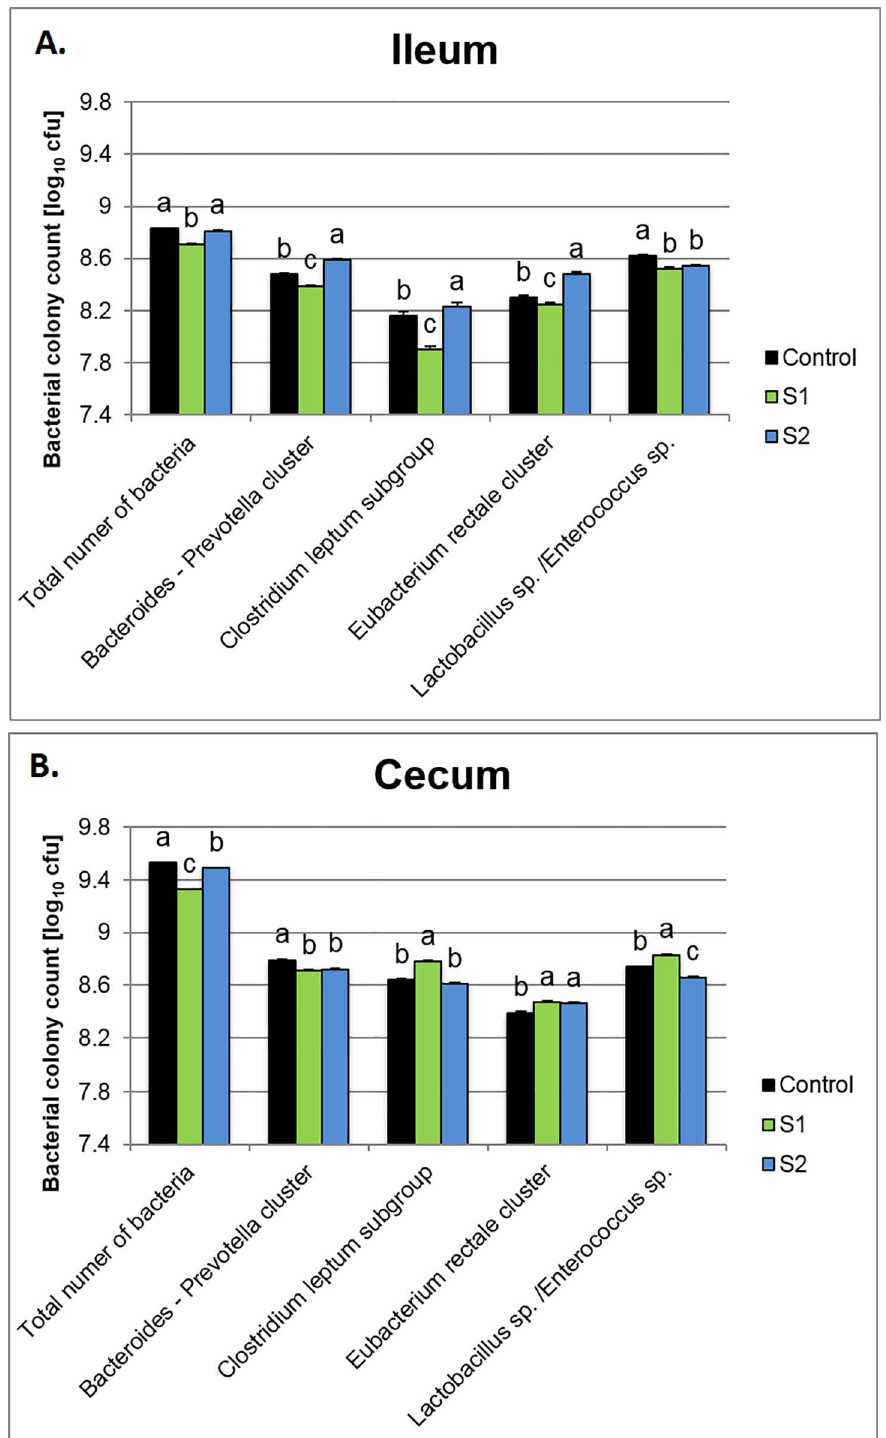
Fig 3. Selected bacterial counts (log cfu/ml digesta) in digesta determined by DAPI staining (total number of bacteria) and fluorescent in situ hybridization (FISH). Hybridization was performed with oligonucleotides, whose sequencewas basedon the literature. A Carl Zeiss Microscope Axio Imager M2 (Carl Zeiss Jena GmbH, Jena, Germany) was used to determine bacterialcount.